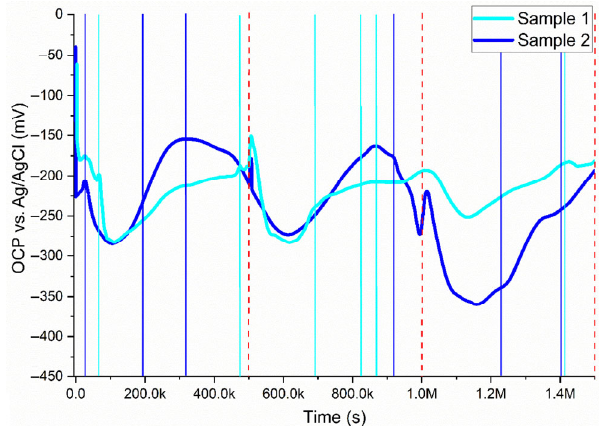
Fig. 2 Variations in the OCP for Samples 1 and 2. The vertical dashed lines represent the serum changing point, and the solid lines represent the machine stopping point.